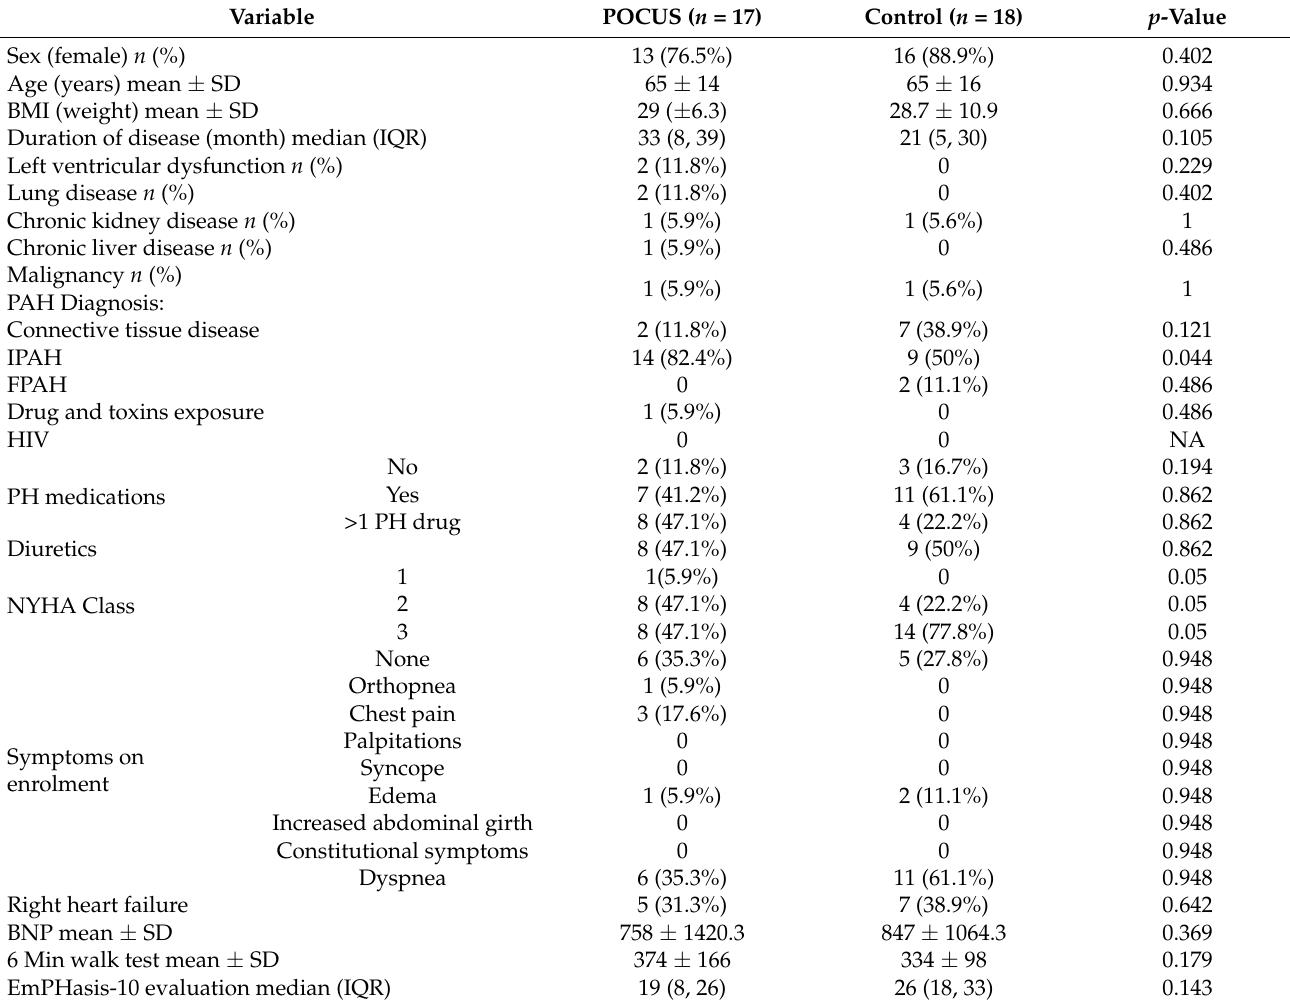
Table 1. Baseline characteristics.